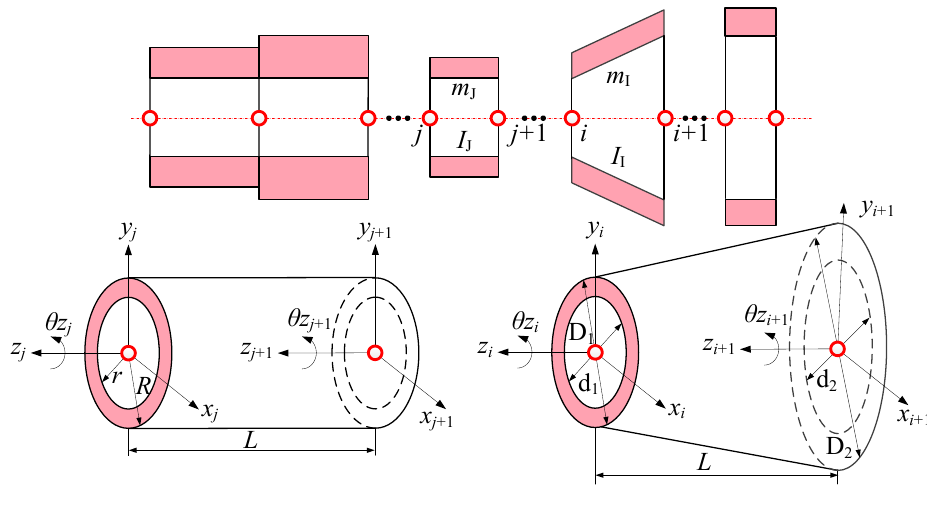
Figure 6. Beam element.